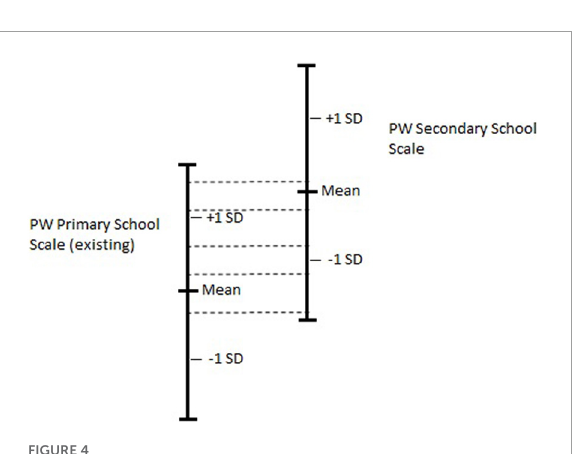
FIGURE4 Schematic showing the scale extension design. Vertical lines represent the extent of the ability